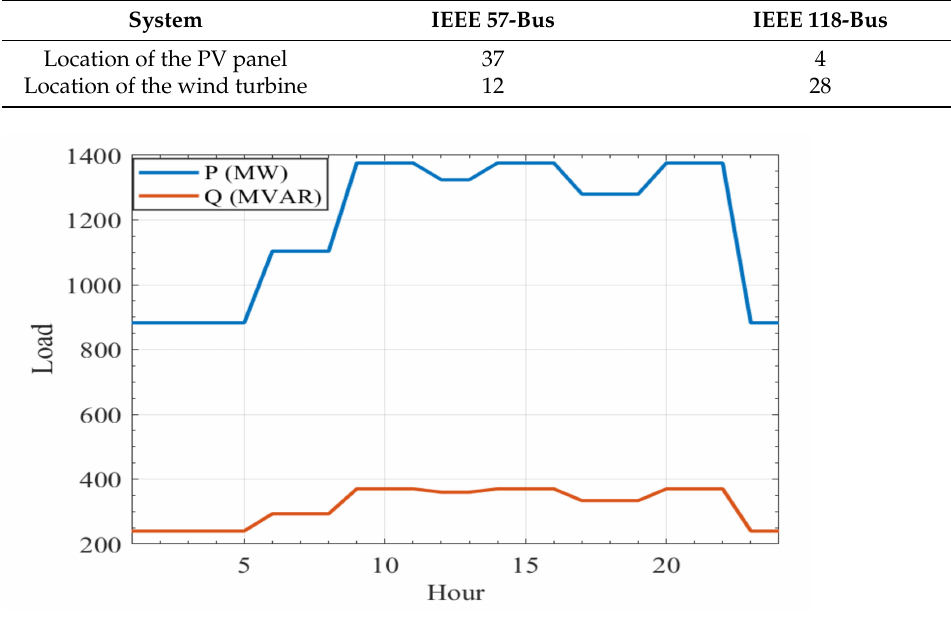
Figure 8. Hourly demand of the 57-bus